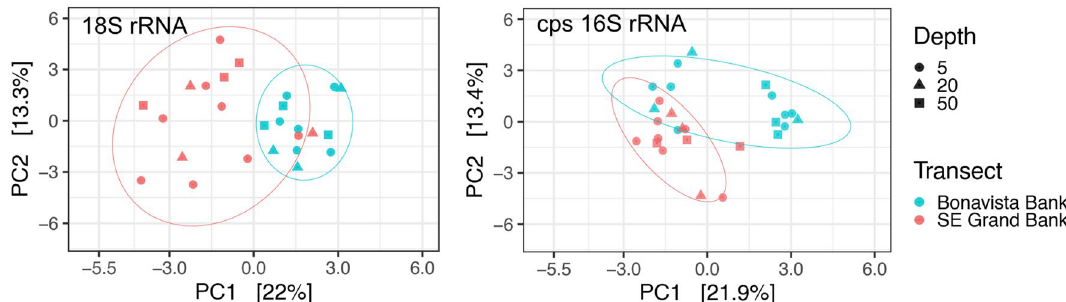
Figure 3. Principal Component Analysis (PCA) of 18S and chloroplast (cps) 16S rRNA markers showing the first (PC1) and second (PC2) most important components (axes) with shapes indicating sample depth